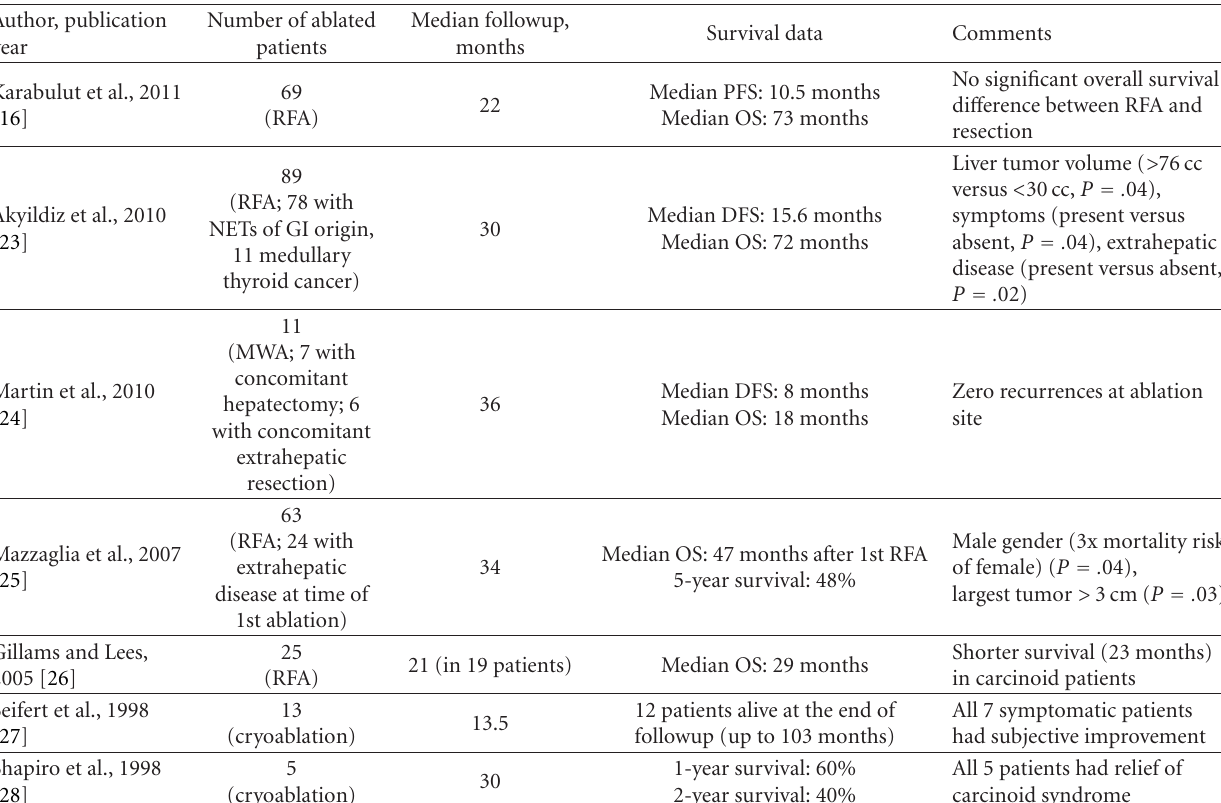
Table 2: Summary of outcomes for ablation of neuroendocrine liver